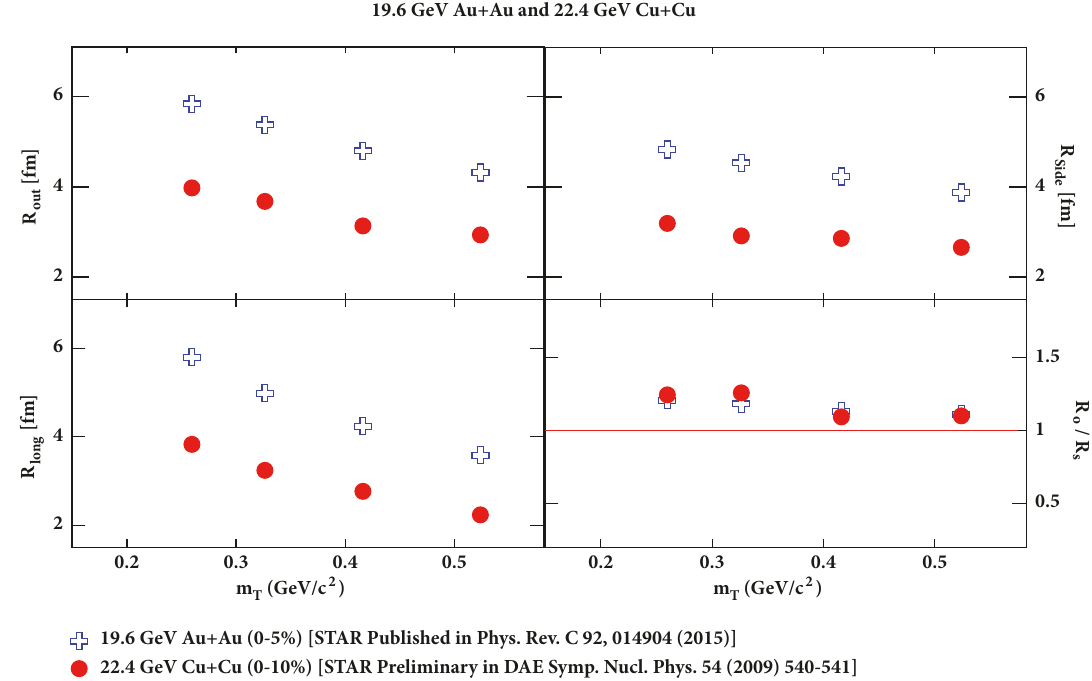
Figure 2: The comparison of system size dependence in HBT radii of STAR Au+Au collisions at √ 𝑠 NN = 19.6 GeV with Cu+Cu collisions at √𝑠 NN = 22.4 GeV. Only statistical errors are shown for the top central data of both the Au+Au and Cu+Cu